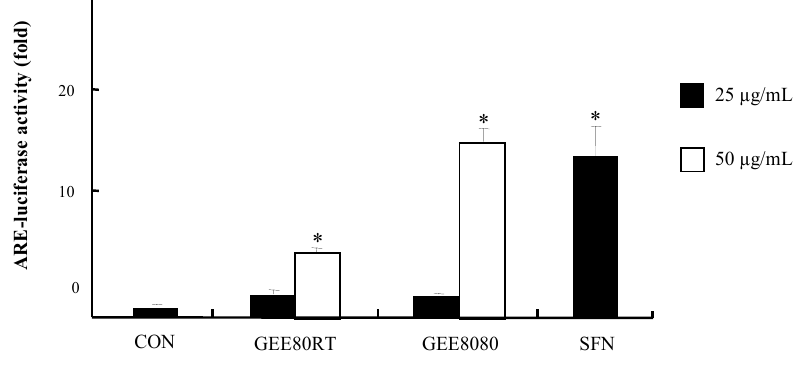
Figure 3. ARE-luciferase activity by ginger extracts in HepG2-C8 cells. HepG2-C8 cells, stably transfected with pARE-T1-luciferase reporter gene, were treated with vehicle (DMSO, 0.1%) or each ginger extract for 12 h. Luciferase activity was normalized with protein content and expressed as fold-induction against vehicle-treated control. Sulforaphane (SFN) was used as a positive control. Values are represented as mean ± SD (n = 5), * significantly different from vehicle treatment, respectively, p <